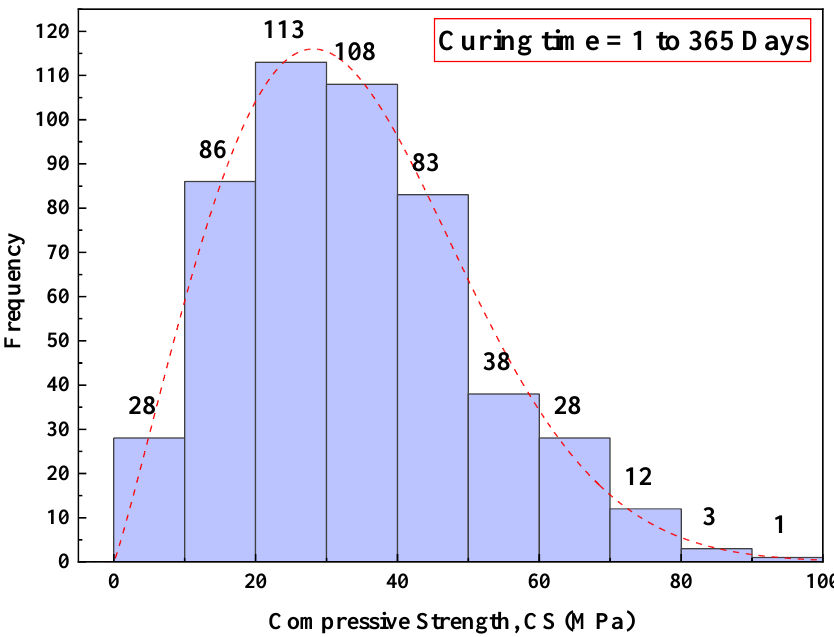
Figure 3. The self- compacting concrete’s compressive strength histogram after being modified with fly ash.